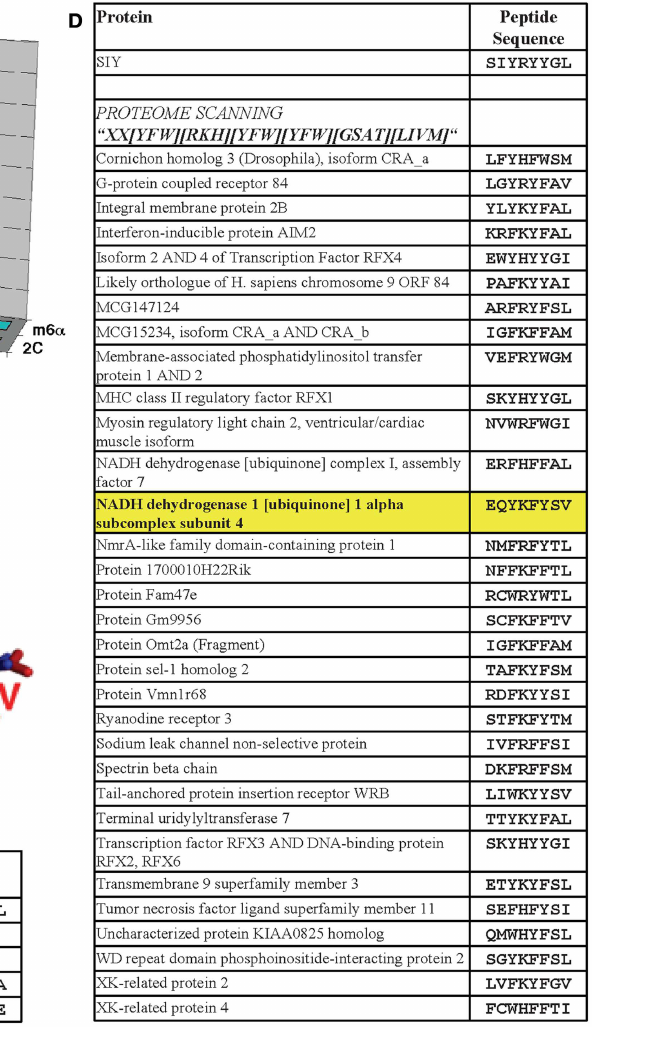
they are structurally very similar [shown here aligned from their H2-K b -bound structures, SIY in blue and dEV8 in red; PDB IDs 1G6R (92) and 2CKB (173)]. (C) Performing a protein BLAST search of the mouse proteome with the SIY peptide sequence string and an Expect value cut off of 5.0 yielded only two sequence-similar peptides. (D) Performing a proteome scan to find sequences similar to SIY, based in part on alanine scan data of the peptide epitope, and the tolerance for mutations at each position yielded 43 peptides considered to be similar (only 33 sequences predicted to bind with SYFPEITHI scores > 16 are shown). Using this technique, the putative positive-selecting peptide, and the self-peptide that reacts with the higher affinityTCR m33 (71), called dEV8 was identified (shown in bold, highlighted in